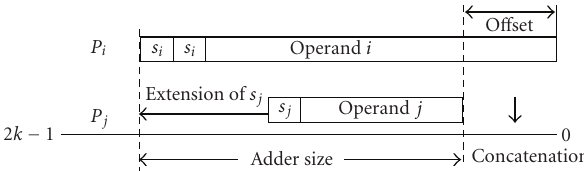
Figure 2: Structure of the adders in the new sign-extension scheme.